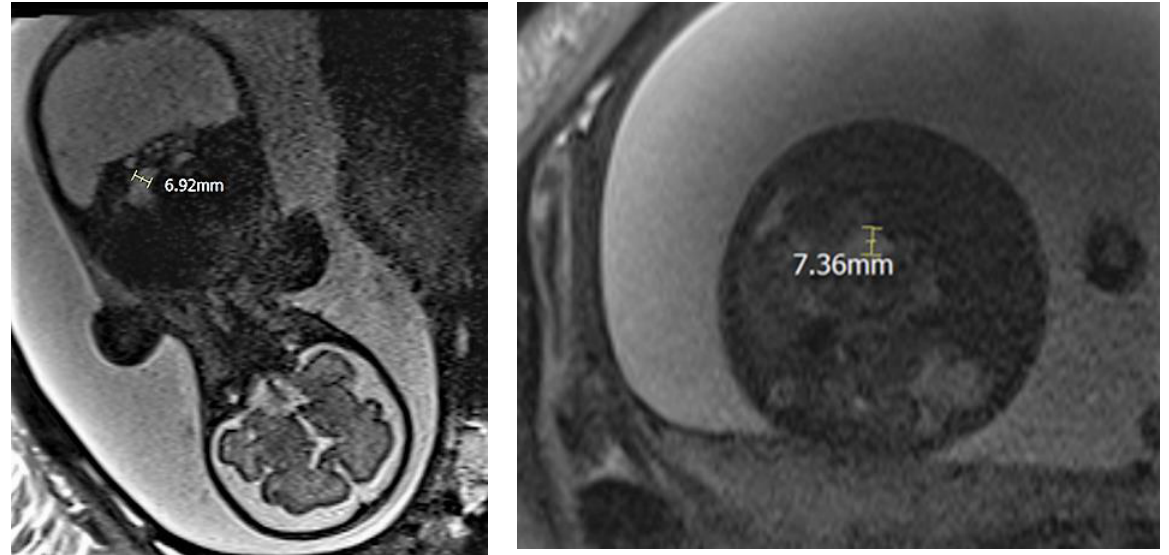
Figure 2. These two MRI images show intestinal dilation > 7 mm and the absence of meconium distal to the obstruction.